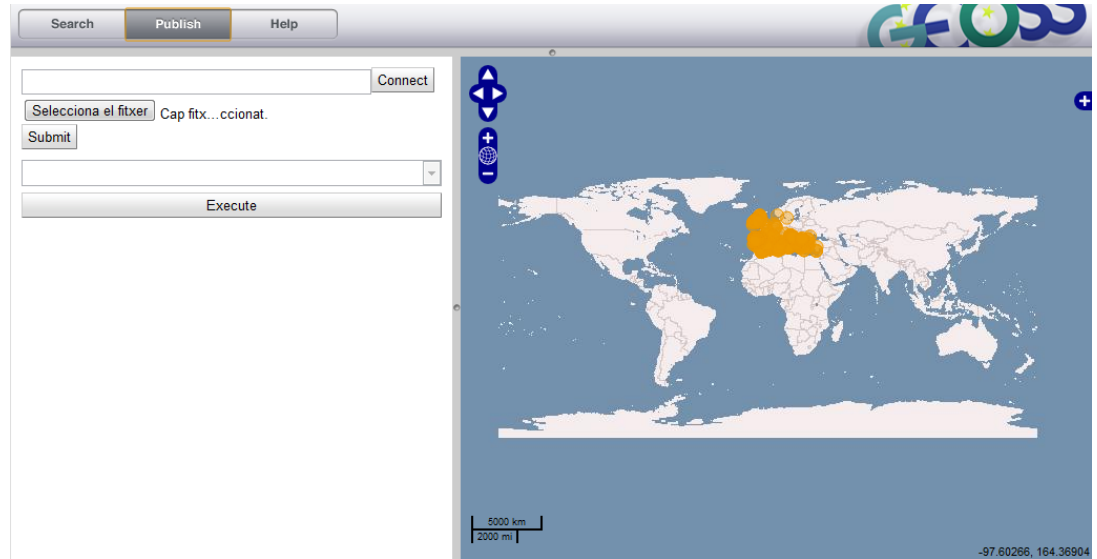
Figure 10. GSF web-based client.